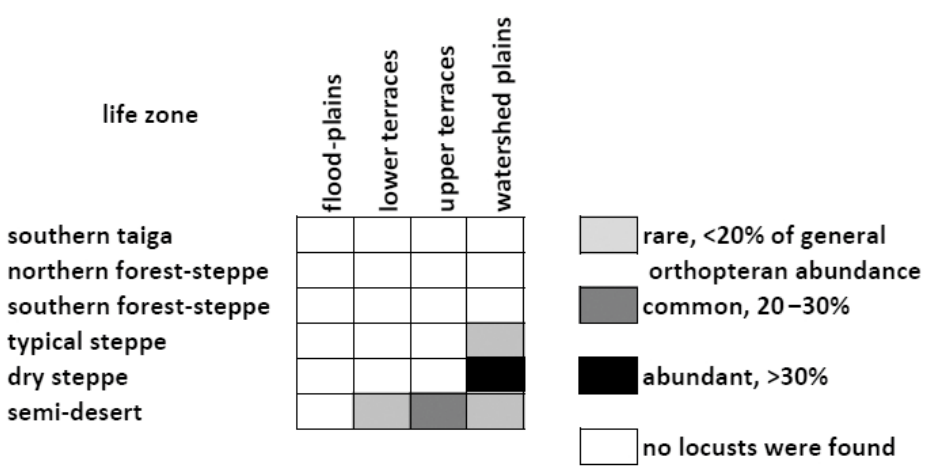
Figure 5. Population distribution of the Italian locust along the Irtysh River in the 1920s (after [26]).